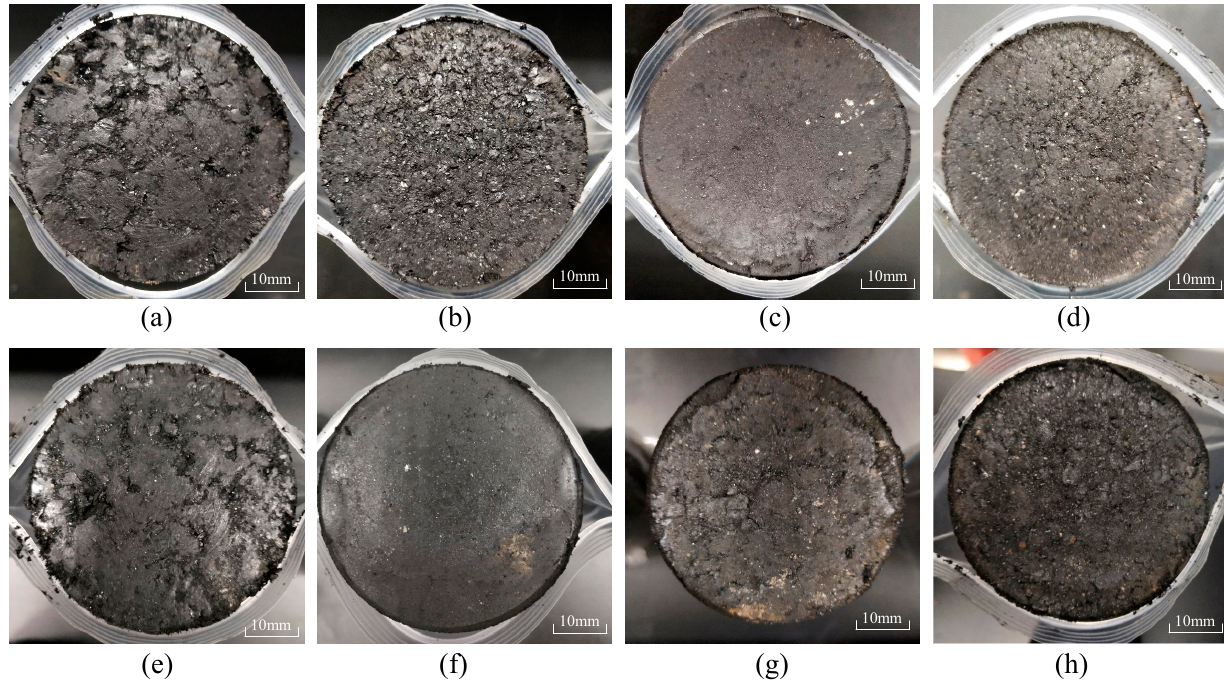
Figure 6. Surface morphology of reconstituted coal formed with different particle content. ( a ) Scheme 1; ( b ) Scheme 2; ( c ) Scheme 3; ( d ) Scheme 4; ( e ) Scheme 5; ( f ) Scheme 6; ( g ) Scheme 7; ( h ) Scheme 8. It can be seen from Table 2 that with the increase of particle size, the P-wave velocity and uniaxial compressive strength of coal samples decrease, and the larger the particle